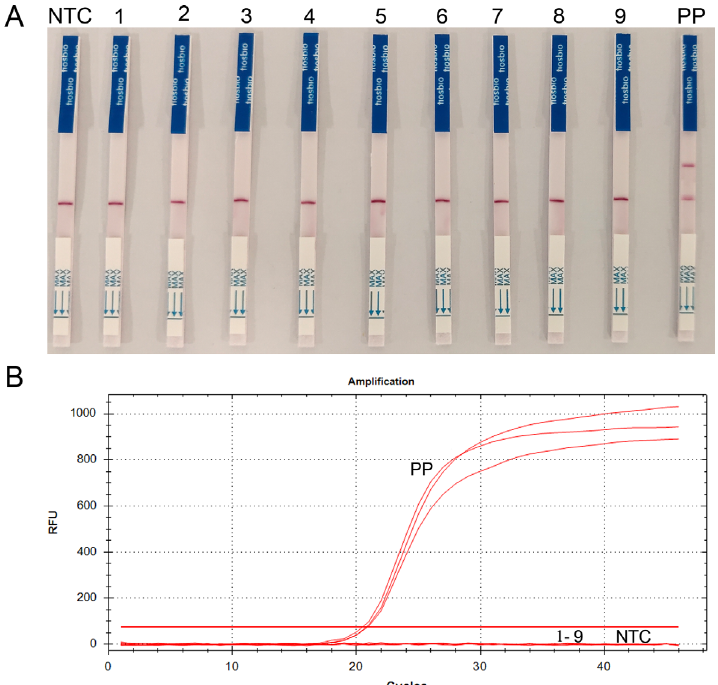
Figure 7. Speci fi city of T. gondii detection by RAA-LFD and qPCR detection. (A) Visual inspection of RAA-Cas13a-LFD. (B) Curves for qPCR. Strip and curves: 1. Human blood; 2. Ascaris lumbricoides ; 3. Digramma interrupta ; 4. Entamoeba coli ; 5. Fasciola gigantica ; 6. Plasmodium vivax ; 7. Schistosoma japonicum ; 8. Taenia solium ; 9. Trichinella spiralis ; PP: Positive plasmid of T. gondii ; NTC: negative control (ddH 2 O).